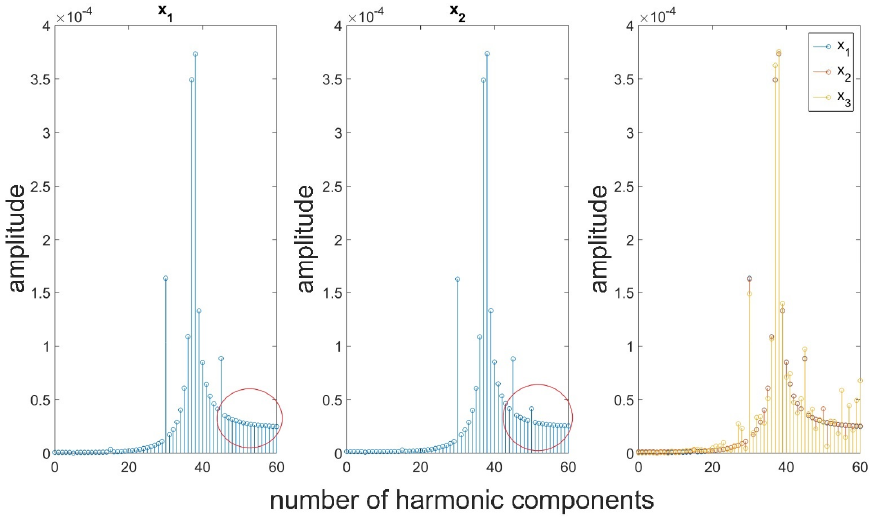
Figure 6. A spectrum of signals on the first level of decomposition.